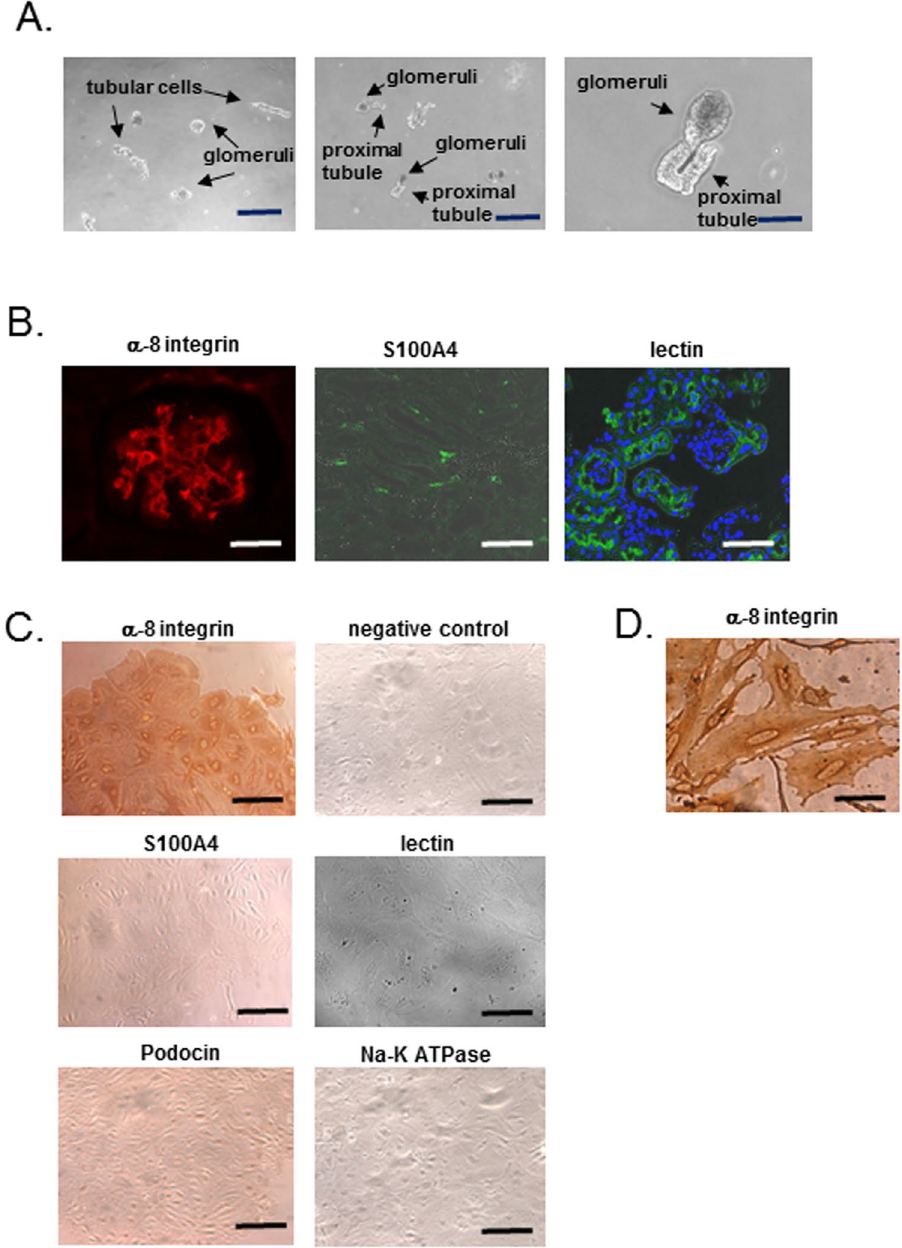
Figure 2. Characterization of primary culture cells. ( A ) The observation of sieving sample under phase- contrast microscope. The sieving sample contains glomeruli and other cells such as tubular cells. Right panel shows sieving sample containing glomeruli connected to proximal tubules. Scale bar, 20 µ m (left and middle panel), 8 µ m (right panel). ( B ) Immunofluorescent staining of α -8 integrin (mesangial cell marker) and S100A4 (fibroblast marker) in kidneys of C57BL/6 J mice. A glomerulus contains cells with positive staining for α -8 integrin, and some cells with positive staining for S100A are observed in glomeruli and tubulo-interstitial cells. Right panel shows proximal tubular cells and their cells invaginated into parietal layer of Bowman’s capsule with the positive staining for lotus tetragonolobus lectin. Scale bar, 20 µ m (left panel), 7 µ m (middle and right panel). ( C ) Immunohistochemistry of α -8 integrin, S100A4 with the negative control, podocin (podocyte marker), Na-K ATPase (tubular cell marker) and fluorescence of lotus tetragonolobus lectin (proximal tubular cell marker) in mesangial primary culture cells. All most of the primary cultured cells exhibit positive staining for α -8 integrin but negative staining for the other markers. Scale bar, 20 µ m. ( D ) High magnification of α -8 integrin staining. The cells after primary culture included an irregular shape and flattened-cylinder-like cell bodies, typical of mesangial cells. Scale bar, 4 µ